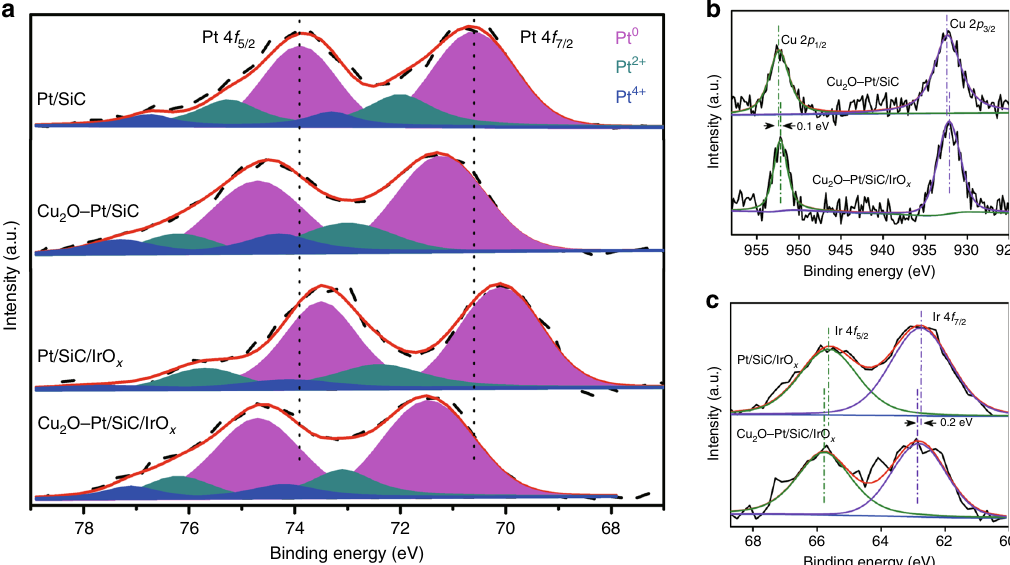
Fig. 4 The chemical states of cocatalysts. a Pt 4 f XPS spectra, b Cu 2 p XPS spectra, and c Ir 4 f XPS spectra of Pt/SiC, Cu 2 O – Pt/SiC, Pt/SiC/IrO x and Cu 2 O – Pt/SiC/IrO x